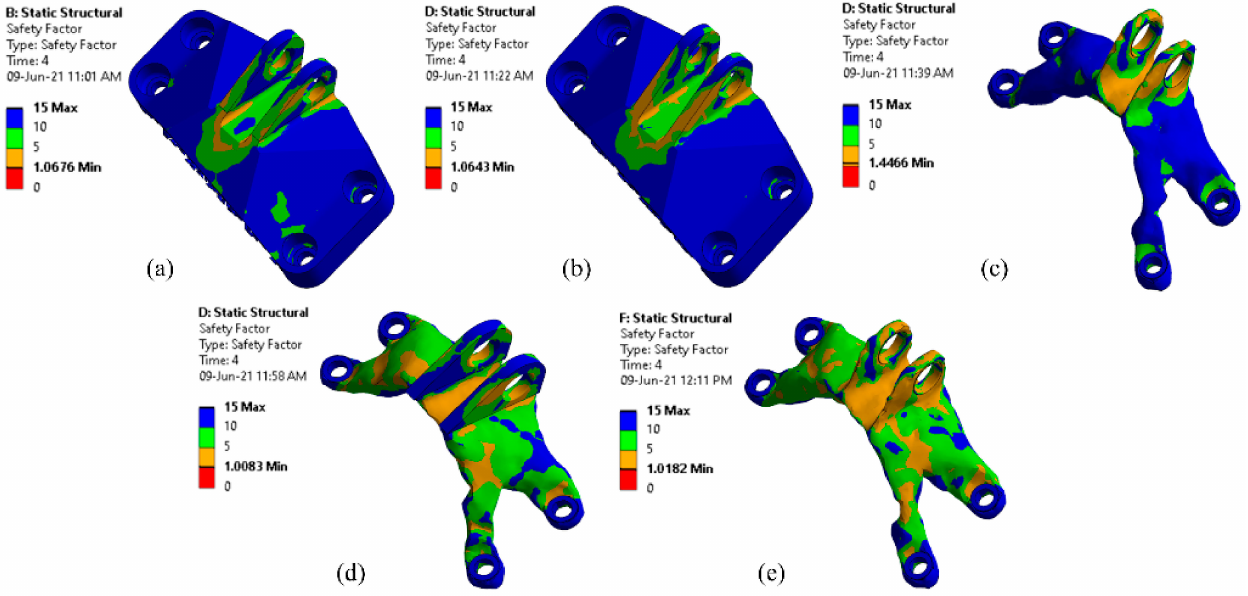
Figure 12. The FOS in the five different optimization methods: ( a ) Lattice, ( b ) LO, ( c ) TO, ( d ) TO_Lattice, and ( e )